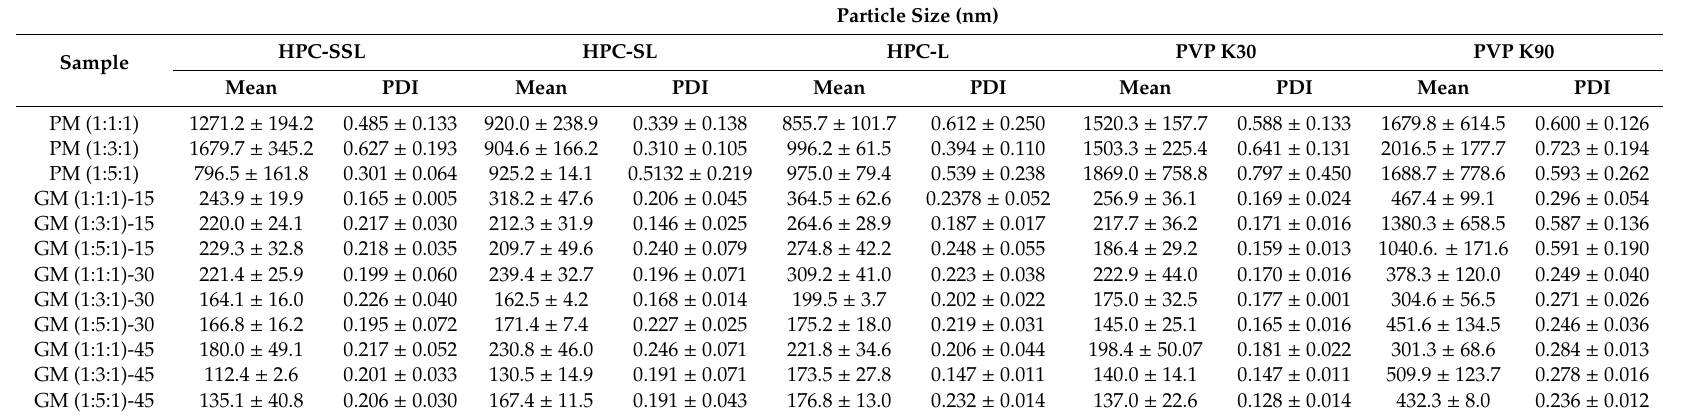
Table 3. Particle sizes of samples.